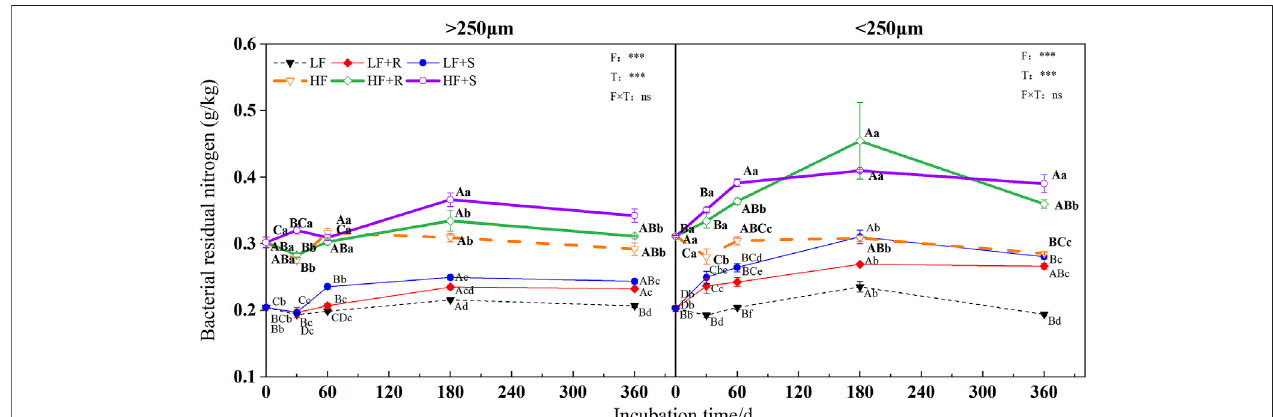
FIGURE5| Bacterialresidualnitrogeninsoilaggregateswithdifferentfertilitylevelsaftertheadditionofdifferentpartsofmaizeresidues.Note:LFmeanslowfertility, LF + R means low fertility + roots, and LF + S means low fertility + Shoots; HF means high fertility, HF + R means high fertility + roots, and HF + S means high fertility + Shoots. Uppercase letters represent differences between different periods in the same treatment, and lowercase letters represent differences between different treatments at the same period. For the ANOVA, F means fertility level, T means type of maize residues, and F × T means fertility level × type of maize residues. *,**, and *** mean P < 0.05, 0.01 and 0.001, respectively. ns means no signi fi cance.